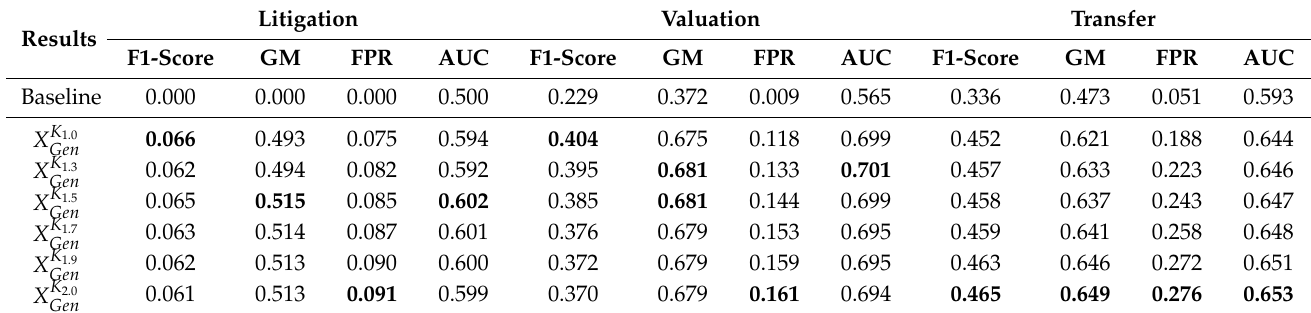
Table A1. Result of comparing the performance to determine the hyperparameter of the proposed